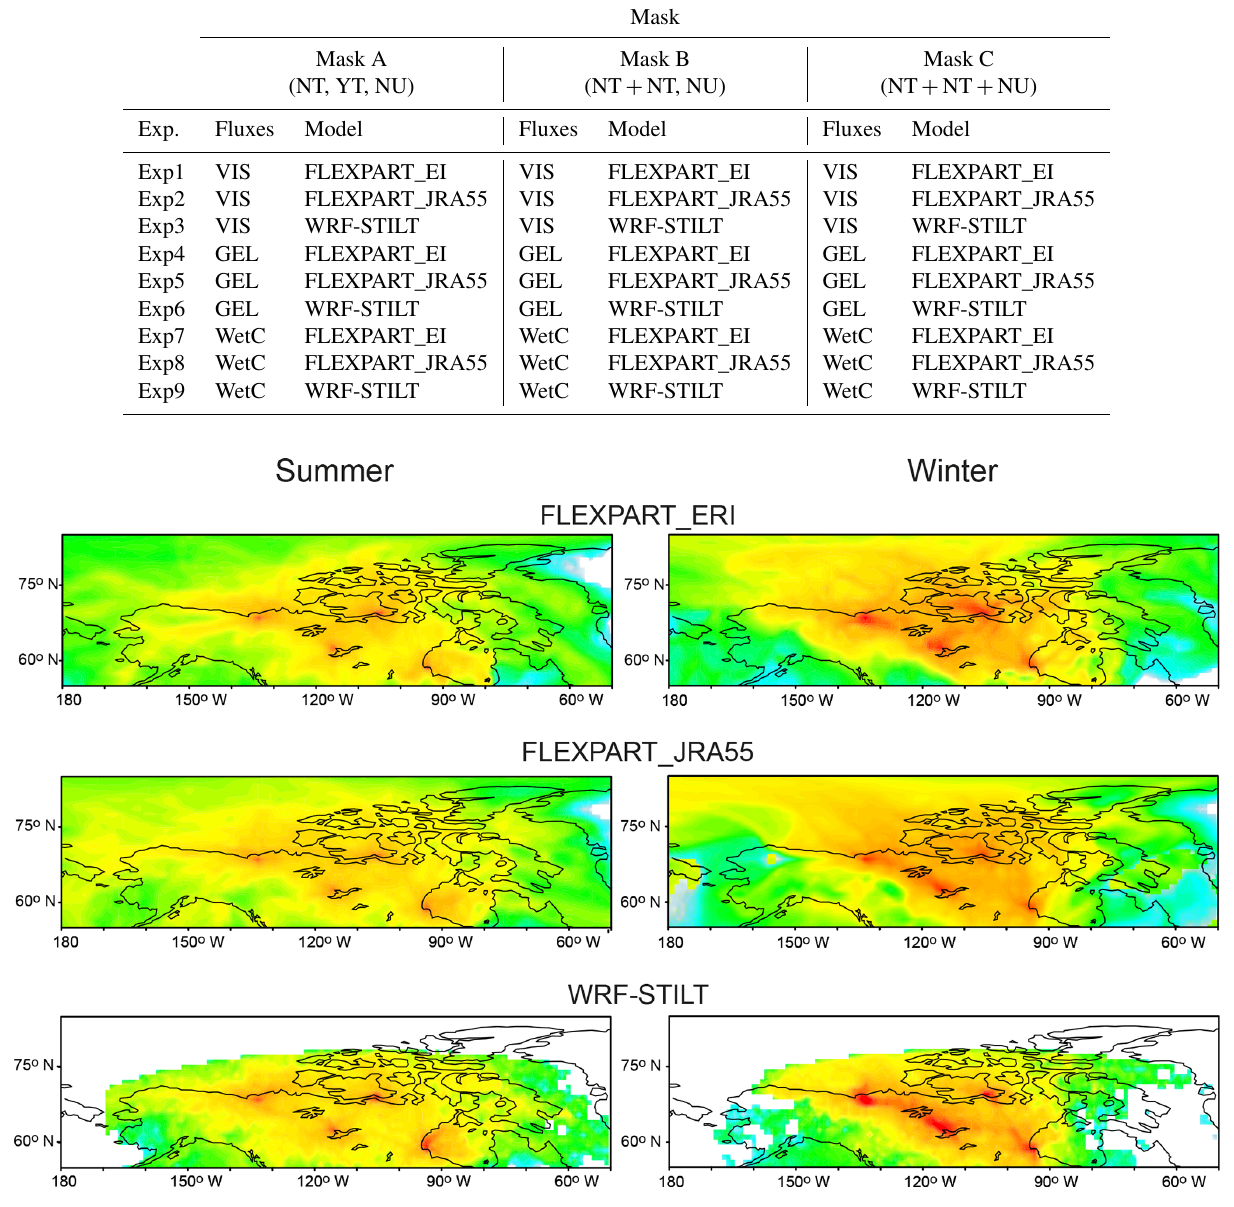
Figure 6. Seasonal mean footprints of all sites by three models, shown for summer (July–August 2013) and winter (January–February